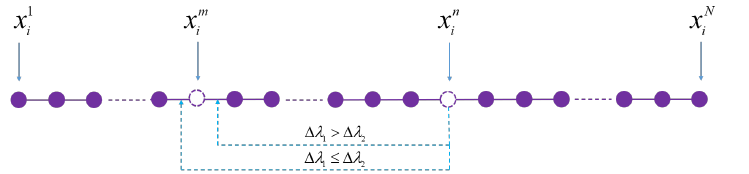
Figure 6. Dynamic neighborhood shift